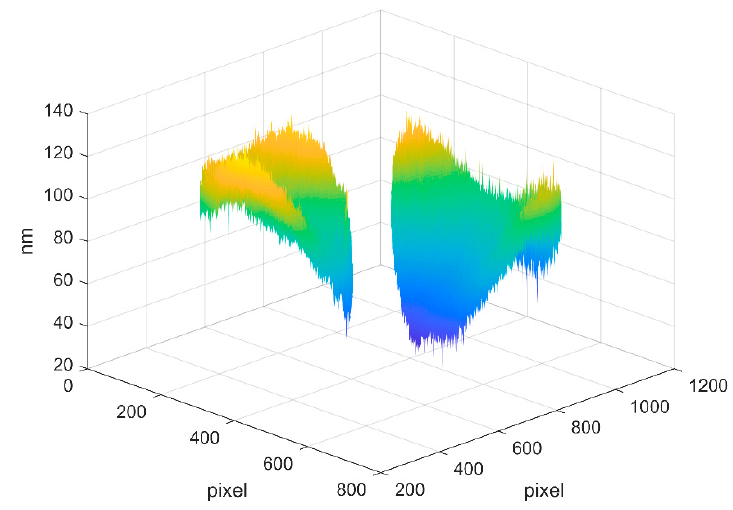
Figure 12. Wavefront of two segments in 663.77 nm (after fine co-phasing).